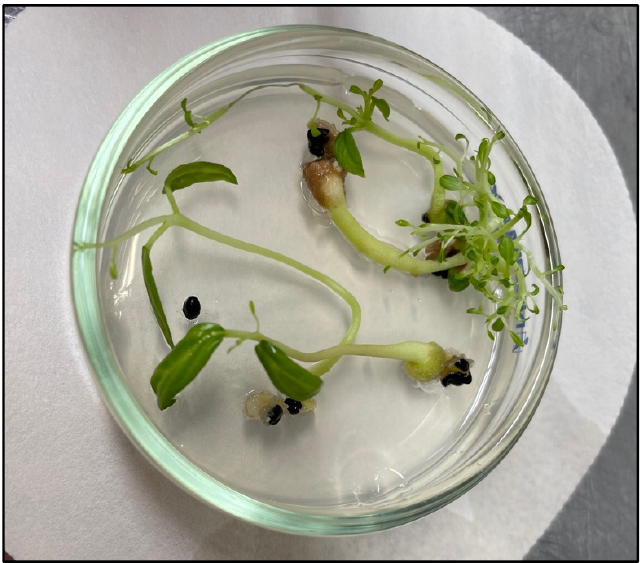
Figure 3. In vitro seed germination and seedling development of caper ( Capparis spinosa